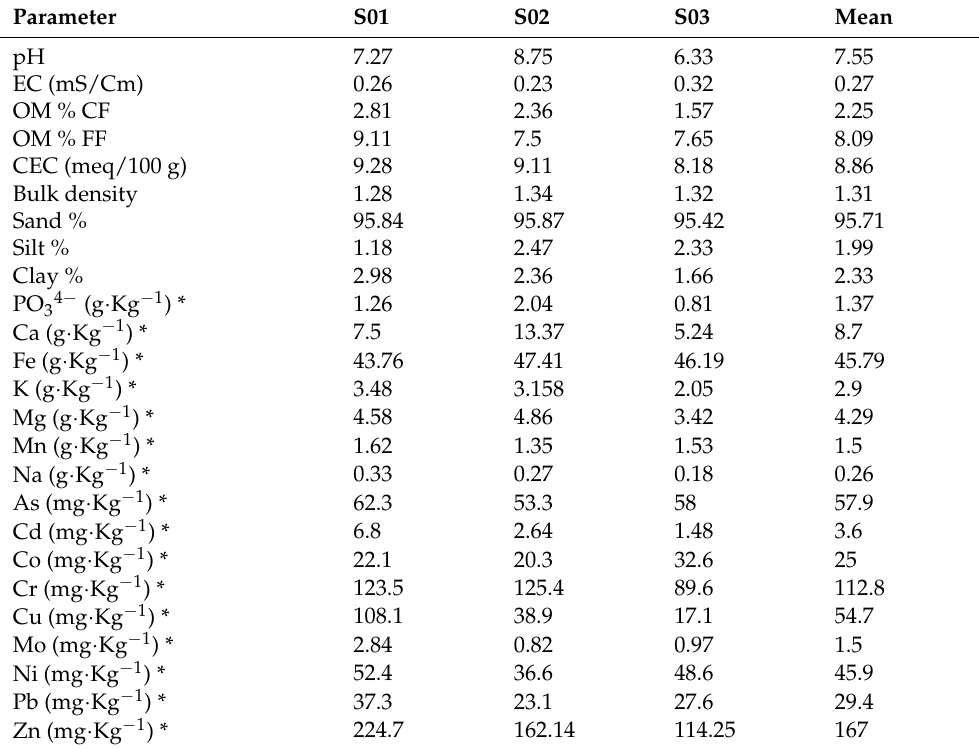
Table 1. Physicochemical analysis of soil